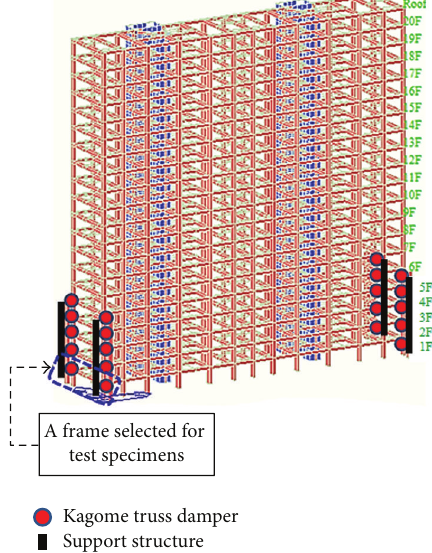
Figure3:Theconsideredexistingreinforcedconcrete(RC)building and installation positions of the support and